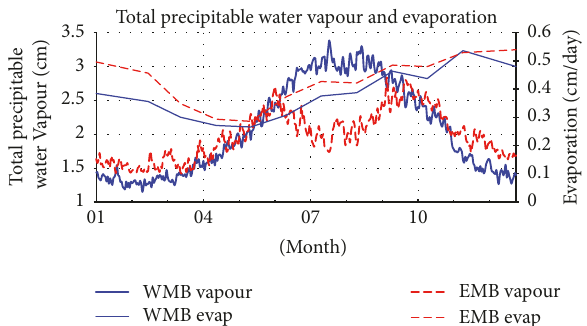
Figure 3: Daily spatiotemporal mean within the two selected boxes andoverelevenyears(2000–2010)ofnetevaporation(thinandthin- dashed lines) and column of TPW column (bold and dotted-bold bell-shaped